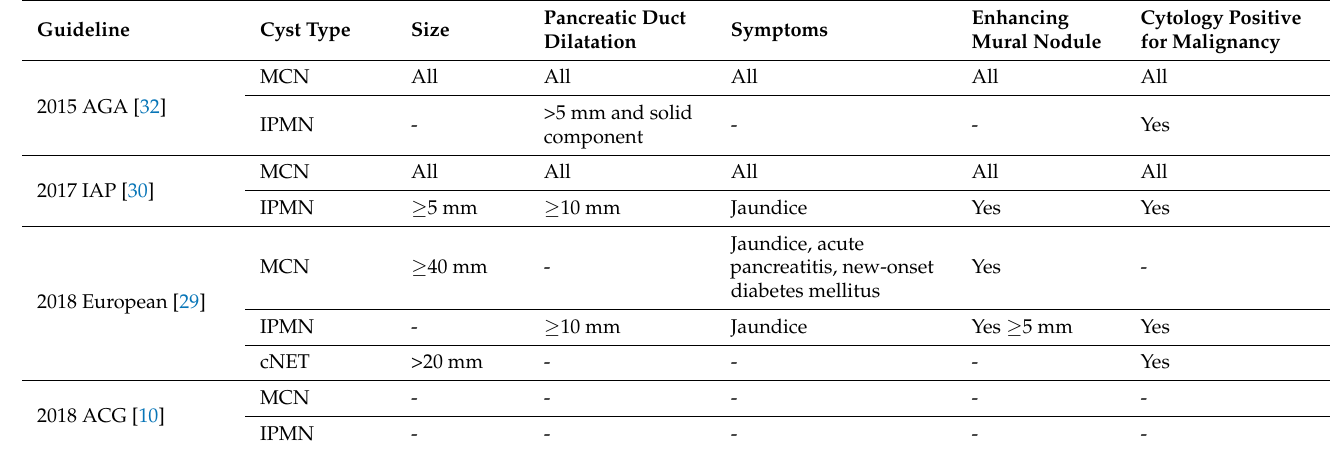
Table 2. Absolute Indications for Surgical Resection of Pancreatic